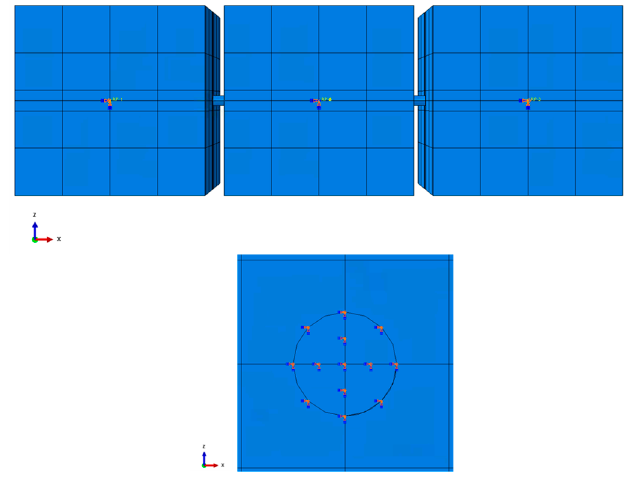
Figure 9. Base ( top ) and fixed end ( bottom ) boundary conditions.